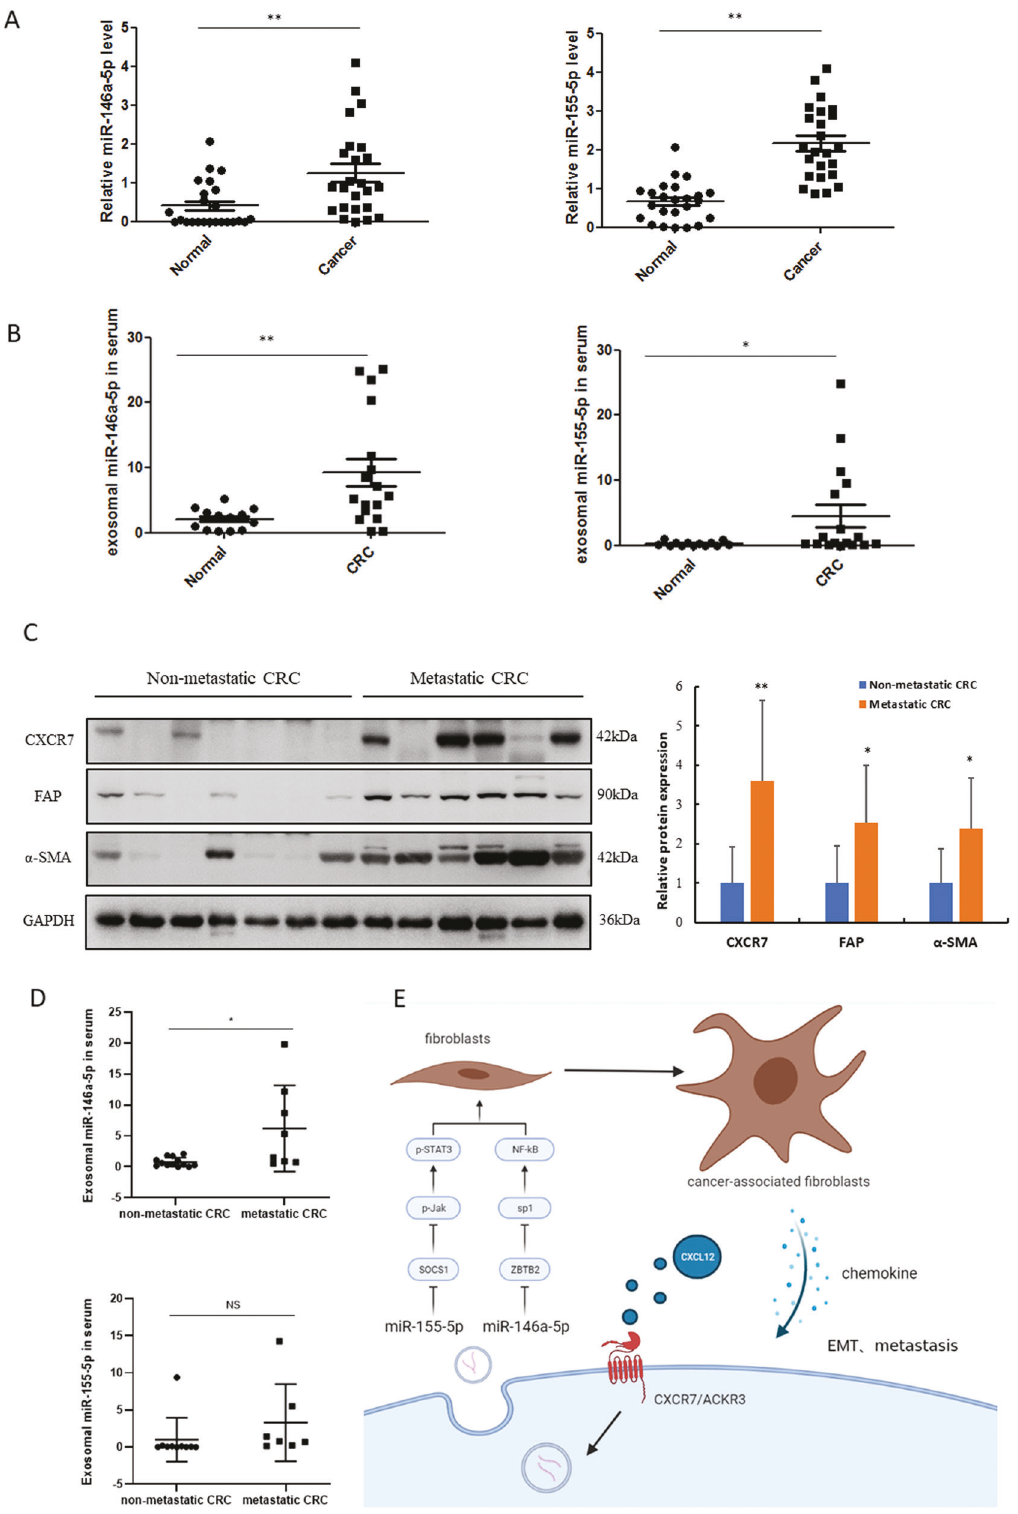
Fig. 8 The level of miR-146a-5p and miR-155-5p was higher in CRC tissues and serum exosomes compared with that of normal counterparts. A Levels of miR-146a-5p and miR-155-5p were determined in colonic tissues of CRC patients and adjacent normal colon tissues ( n = 24). B RT-qPCR analysis of exosomal miR-146a-5p and miR-155-5p in the serum of CRC patients ( n = 17) and healthy volunteers ( n = 13). * p < 0.05, ** p < 0.01 vs. control. C Western blot analysis of expression levels of CXCR7, FAP, and α -SMA in CRC patients with ( n = 7) and without ( n = 10) distant metastasis. D RT-qPCR analysis of exosomal miR-146a-5p and miR-155-5p in the serum of non-metastatic ( n = 10) and metastatic ( n = 7) CRC patients. * p < 0.05. E The scheme depicts the intercellular communications between CXCR7-overexpressing CRC cells and activation of CAFs through exosomal miRNAs.